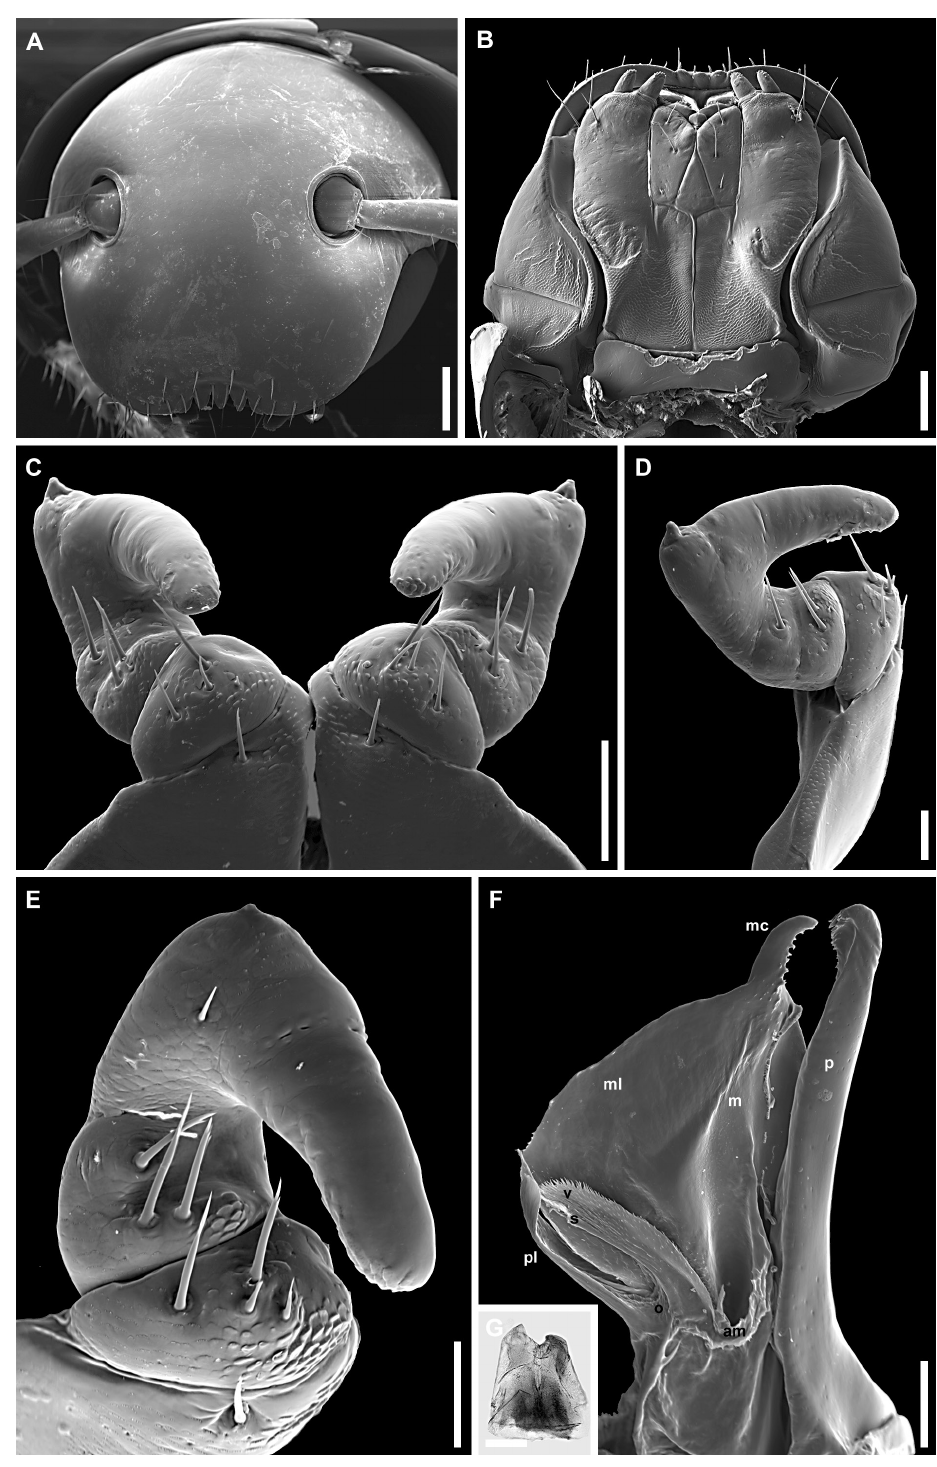
Fig. 4. Leucogeorgia abchasica (Lohmander, 1936) comb. nov. (A–F: ♂ from Bolshaya Medveditza Cave (ZMUM); G: ♂ from Uatapachy Cave (ZMUM)). A . Head, anterior view. B . Head, ventral view. C . Leg-pair 1, anterior view. D . Left leg 1, lateral view. E . Left leg 1, distolateral view. F . Right gonopods, mesal view. G . Penes, anterior view. Abbreviations: am = accessory membrane; m = mesomere; mc = mesomeral claw; ml = mesomeral lamella; o = opisthomere; p = promere; pl = protective lamella; s = solenomere; v = velum. Scale bars: A–B = 0.2 mm; C, F–G = 0.1 mm; D–E = 0.05